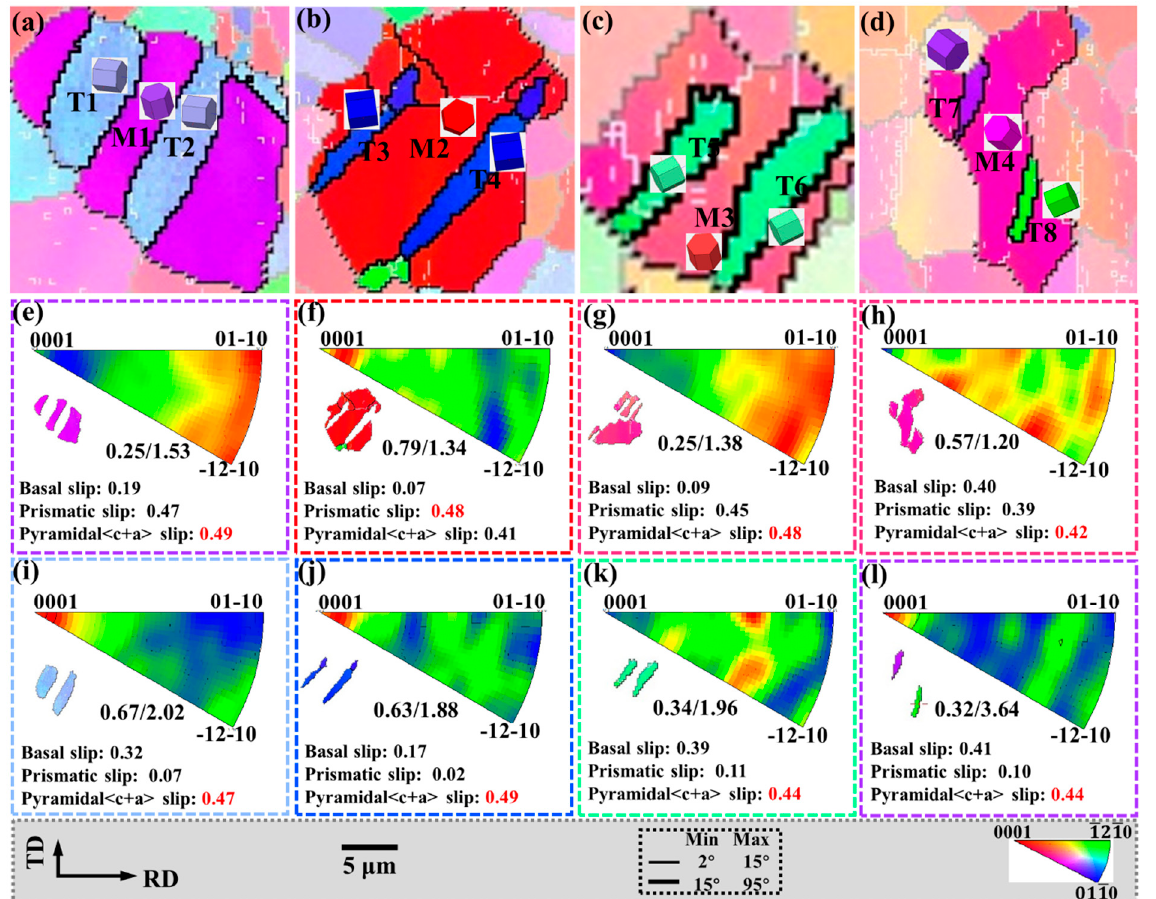
Figure 10. IGMA of parallel twins: ( a – d ) the IPF, ( e – h ) IGMA of the matrix, and ( i – l ) IGMA of the twins.